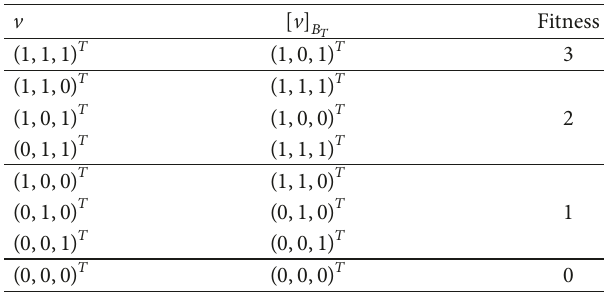
Table 2: The vectors with a modified basis 𝐵 𝑇 and the original vectors in the onemax problem of size